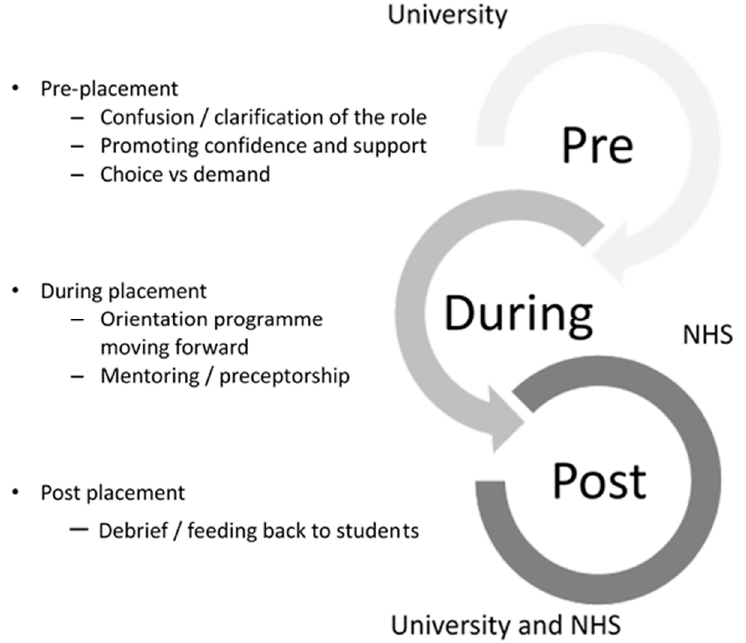
Figure 2. The PDP Student Nurses Placement Framework.